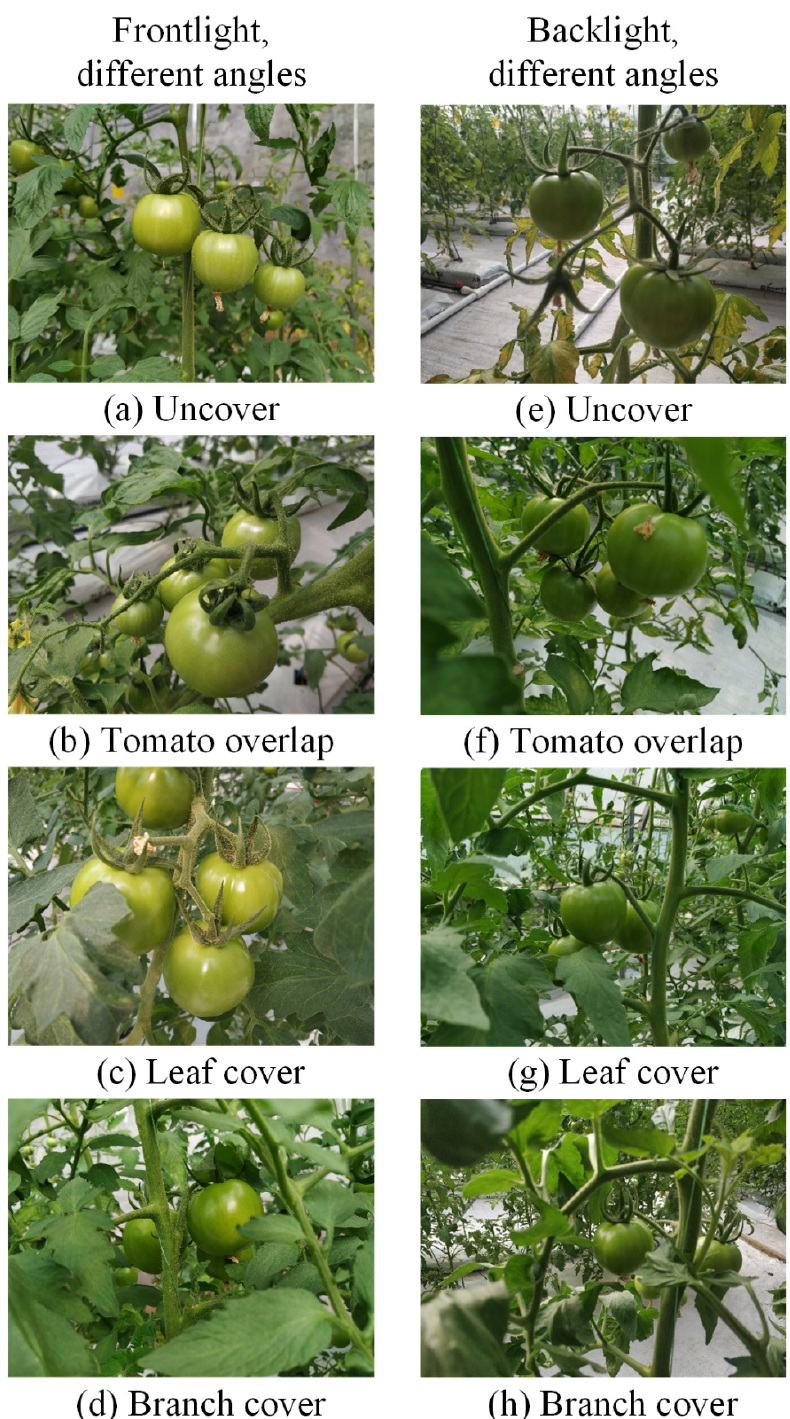
Figure 3. Images of mature green tomatoes from different angles under positive light and backlight